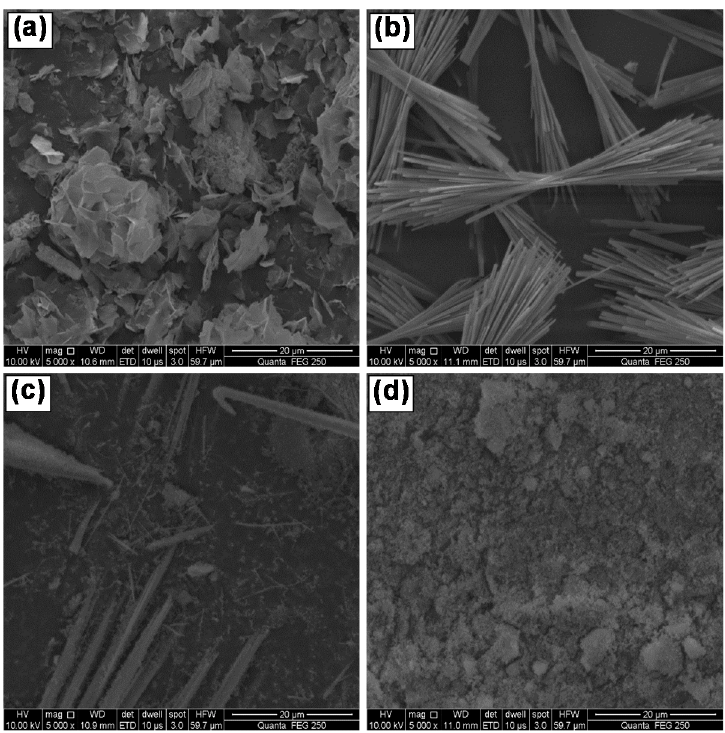
Figure 9. Morphologies of whiskers obtained at different MgSO 4 /NaOH mole ratios ( a ) 3:1; ( b ) 2:1; ( c )